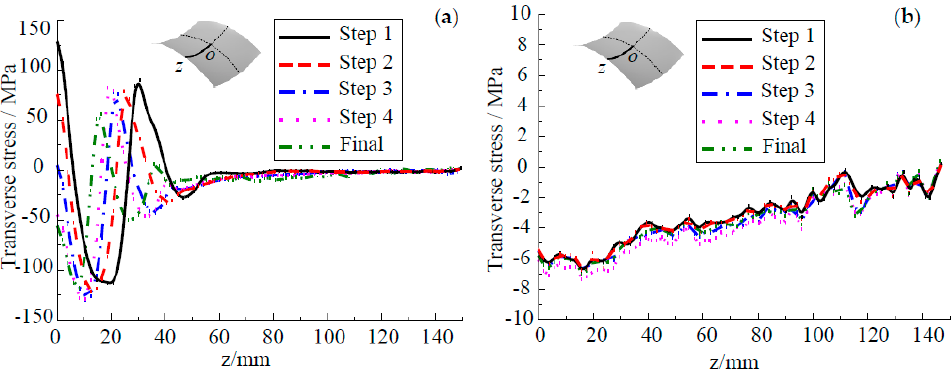
Figure 14. Transverse stresses of the saddle-shaped part at different steps. ( a ) C-SF; ( b ) UC-SF.